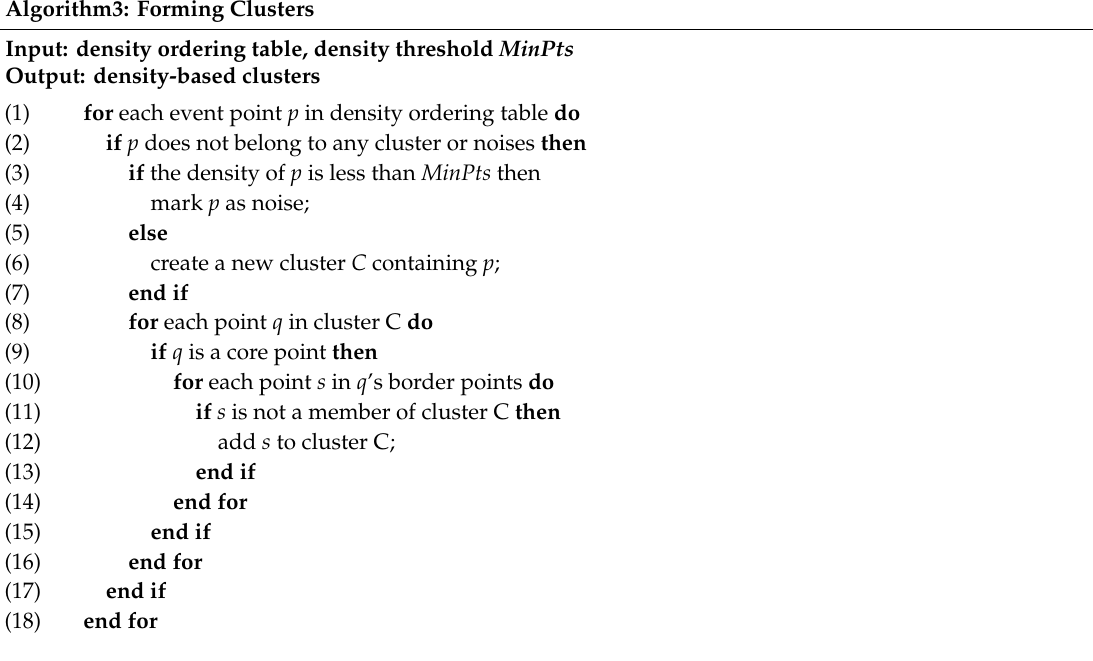
Table 3. Pseudocode of Forming